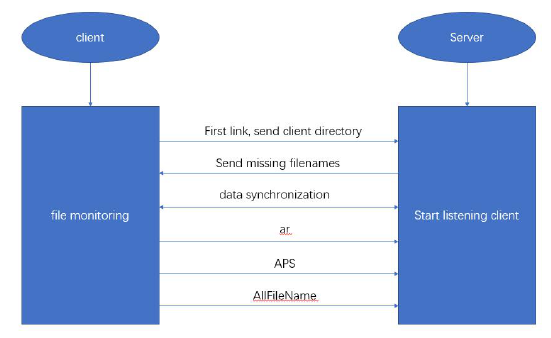
Figure 9 . Connection